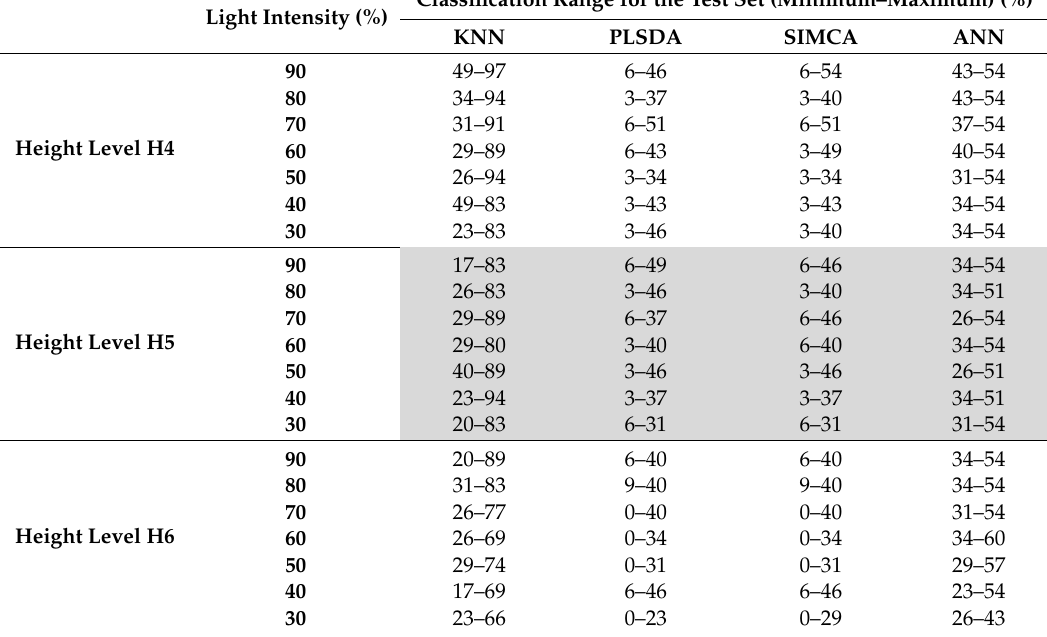
Light Intensity